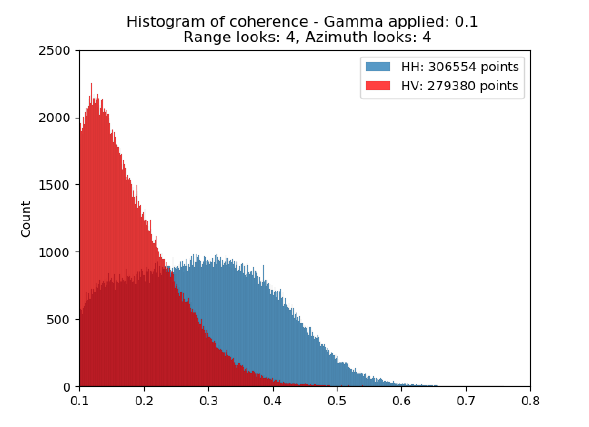
Figure 10. Histogram of coherence for the subsets of HH and HV of figure 8, after applying a γ threshold of 0.1. The number of points to be processed in both channels is now more equal.